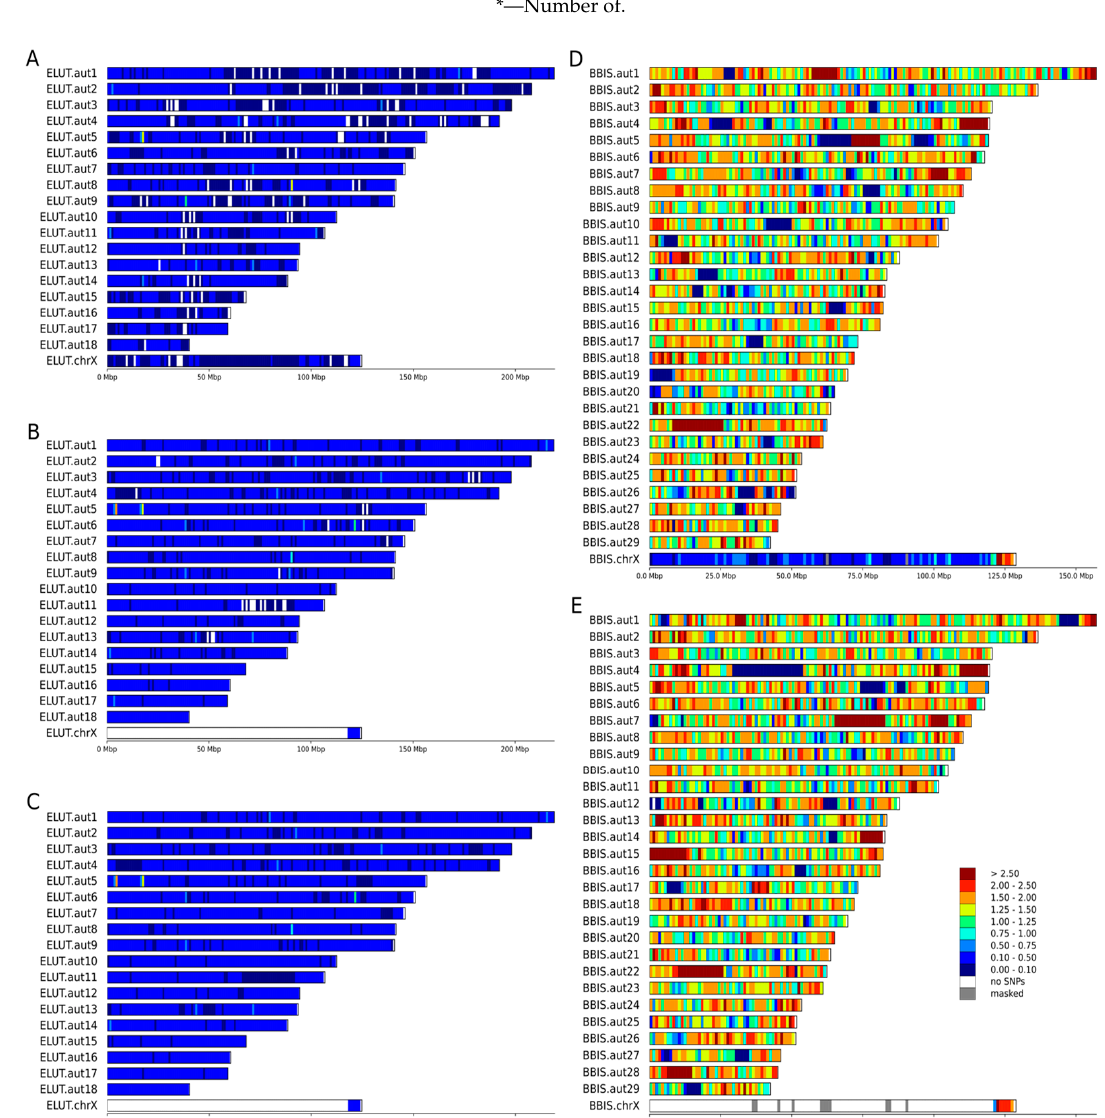
Figure 2. Chromosome-level heatmaps of heterozygosity (density of heterozygous SNP) for two additional species. Individuals of both sexes were available for two the species, sea otters ( Enhydra lutris ) and the American bison ( Bison bison ). Heterozygous SNPs were counted in 1 Mbp windows and scaled to SNP/kbp. ( A ) female sea otter (SRR8597300), ( B , C ) male sea otters (SRR5768046, SRR5768052), ( D ) female bison (SRR8588177), ( E ) male bison (SRR8588180).